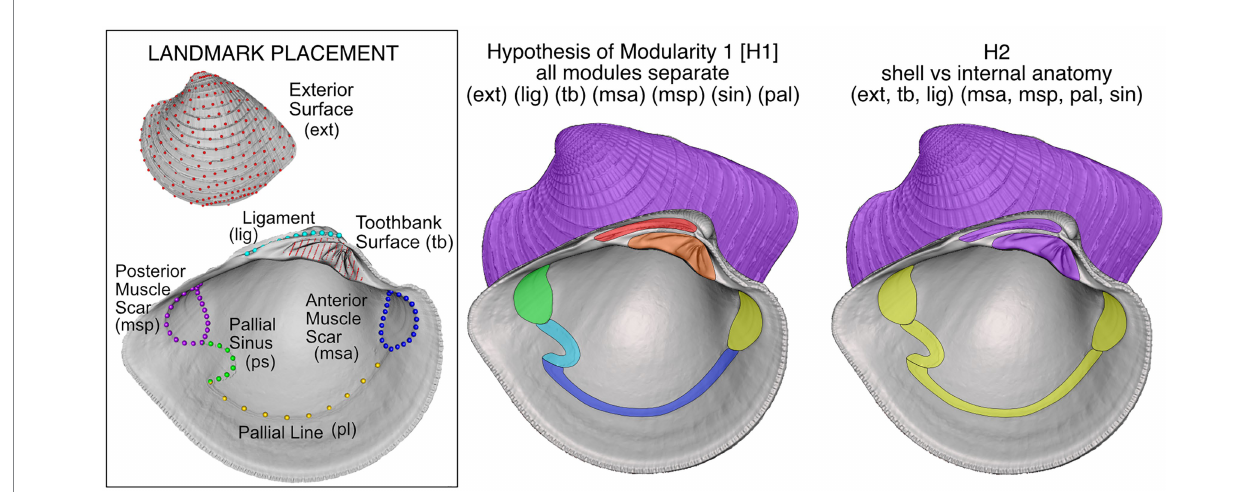
FIGURE 7 Geometric morphometric landmarking of shell features and hypotheses of modularity and integration in the venerid bivalve Chionopsis amathusia (Philippi 1844). Hypothesis of modularity “H1” was the working hypothesis, with all potential modules varying independently, but H2, with just two discrete modules, was best supported by morphometric analysis (adapted from Edie et al.,